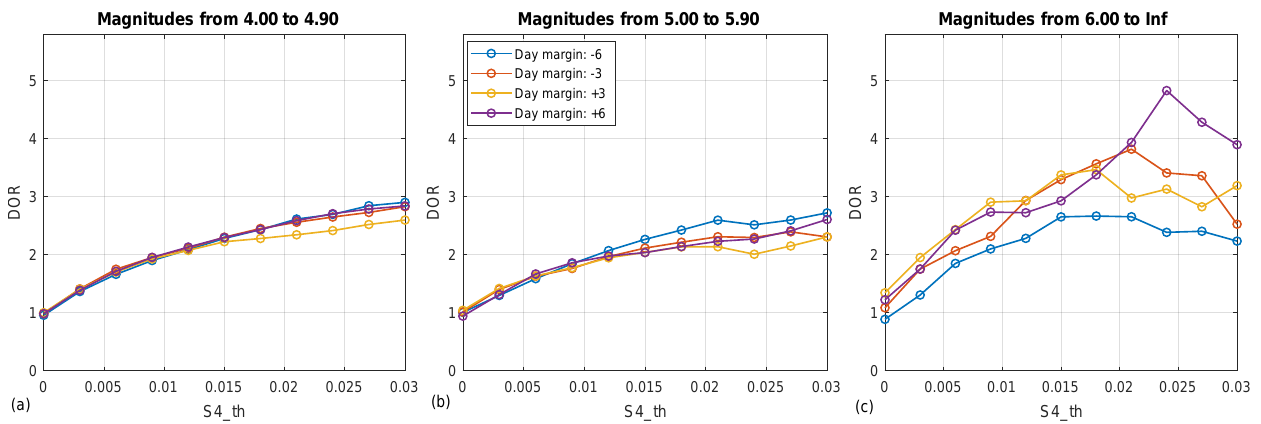
Figure 16. DOR values for two magnitude intervals using radius = 100 km with respect to the ∆ S 4 threshold: s 4_ th .